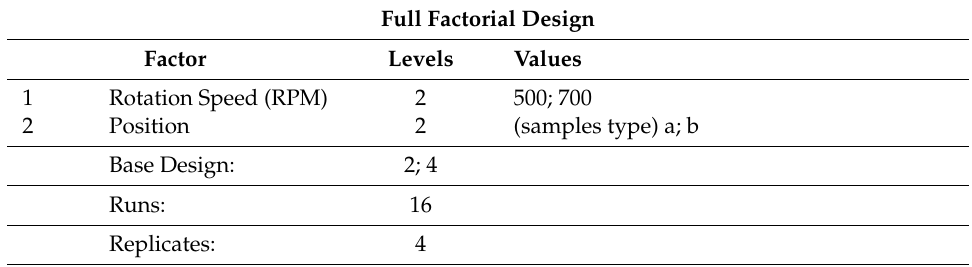
Table 7. General Linear Model: UTS versus traverse speed, rotation speed, and position of samples along the welding direction.